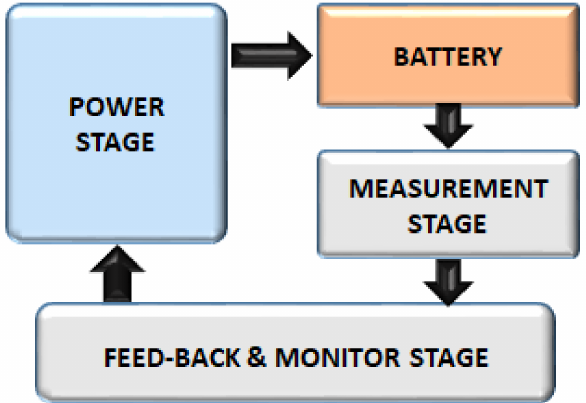
Figure 5. Battery charger block diagram; this work focuses on power